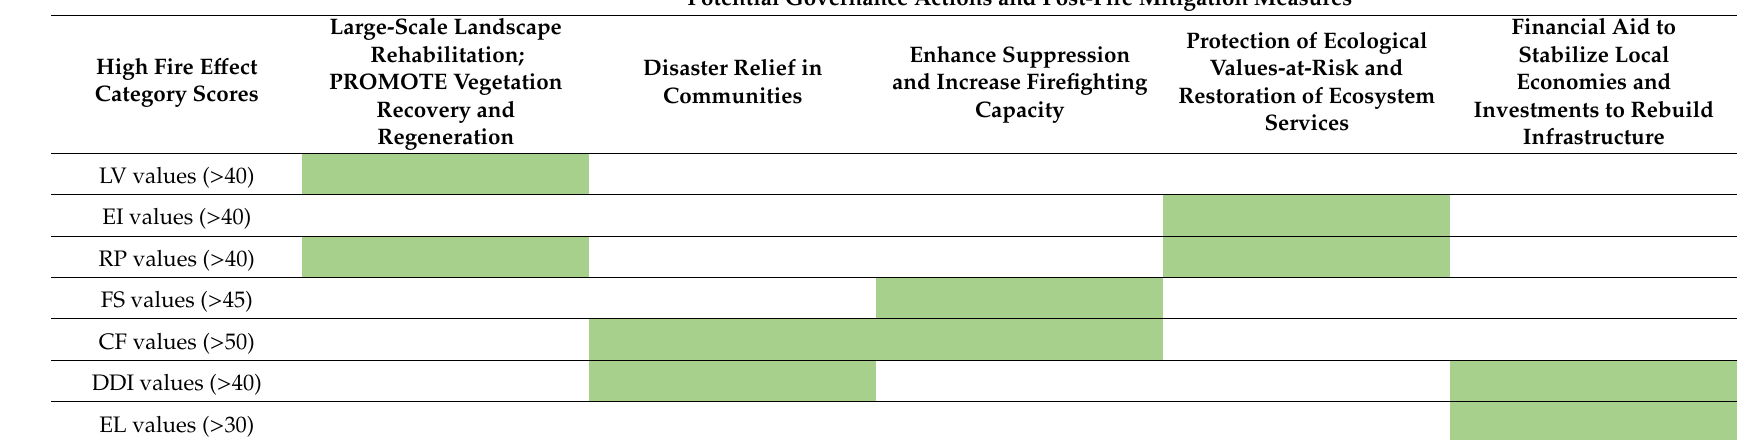
Table 11. Potential governance actions and post-fire mitigation measures that can be applied after each fire, based on which fire e ff ect categories scored high values (highlighted with green